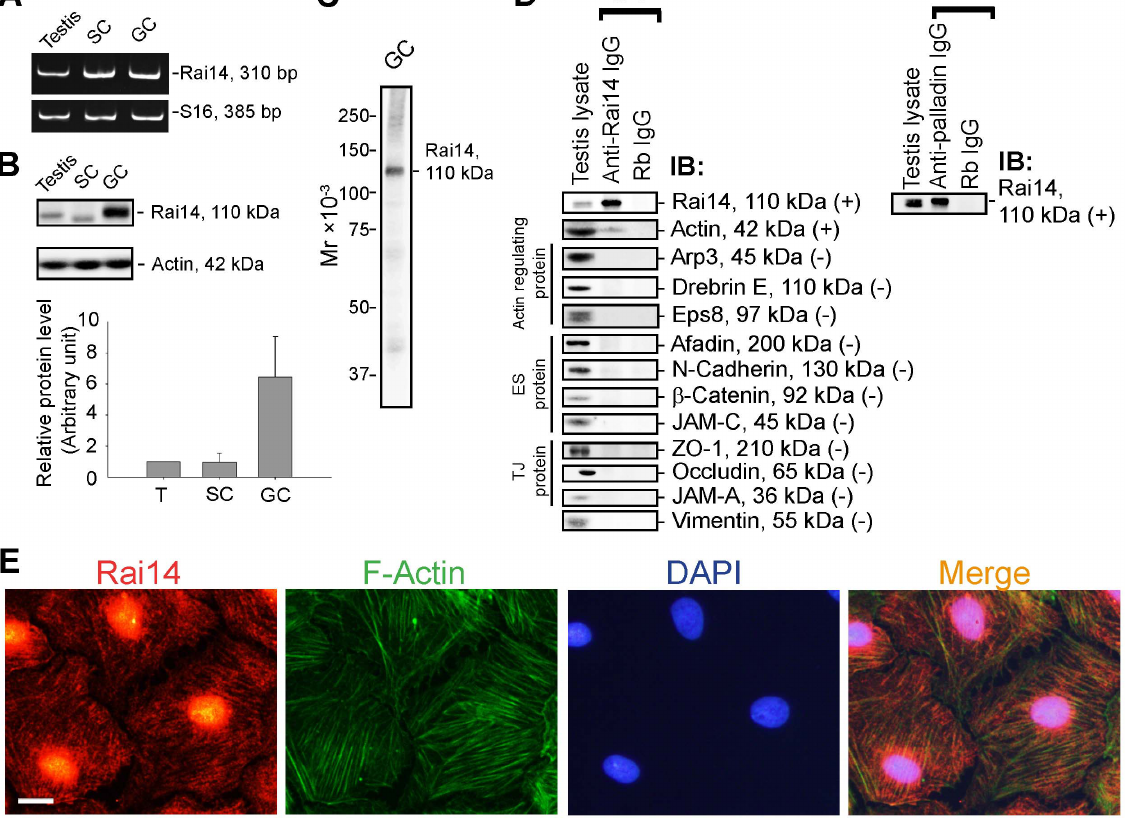
Figure 1. Rai14 is an actin-binding protein in the rat testis. ( A ) A study by RT-PCR to confirm the expression of Rai14 in adult rat testis, Sertoli cells (SC, isolated from 20-day-old rat testes and cultured for 4-day), and germ cells (GC, isolated from adult rat testes and cultured for 16 hr). ( B ) Immunoblotting also confirmed the expression of Rai14 in the rat testis, Sertoli and germ cells, and the relative expression of Rai14 in SC vs. GC was shown in the histogram with n =3 experiments in which the relative expression level of Rai14 in the testis was arbitrarily set at 1 so that the relative expression level between these samples can be compared. ( C ) The specificity of the anti-Rai14 antibody ( Table 1 ) was assessed by immunoblotting using lysates of GC (20 m g protein). ( D ) Using the specific anti-Rai14 antibody, Rai14 was shown to be an actin-binding protein by co- immunoprecipitation (Co-IP); however, Rai14 did not structurally interact with any of the BTB-associated proteins including several actin-binding and regulatory proteins ( e.g ., Arp3, drebrin E, Eps8) and vimentin (an intermediate filament-based constituent protein). However, Rai14 was found to structurally interact with an actin cross-linking protein palladin which is known to be involved in conferring actin filament bundles in other mammalian cells [48]. ( E ) Rai14 (red) was also shown to be an actin-binding protein by dual-labeled immunofluorescence analysis in which it co- localized with F-actin (green) in Sertoli cells. Cell nuclei (blue) were visualized by DAPI. Scale ba =20 m m, which applies to all other micrographs. doi:10.1371/journal.pone.0060656.g001 PLOS ONE |